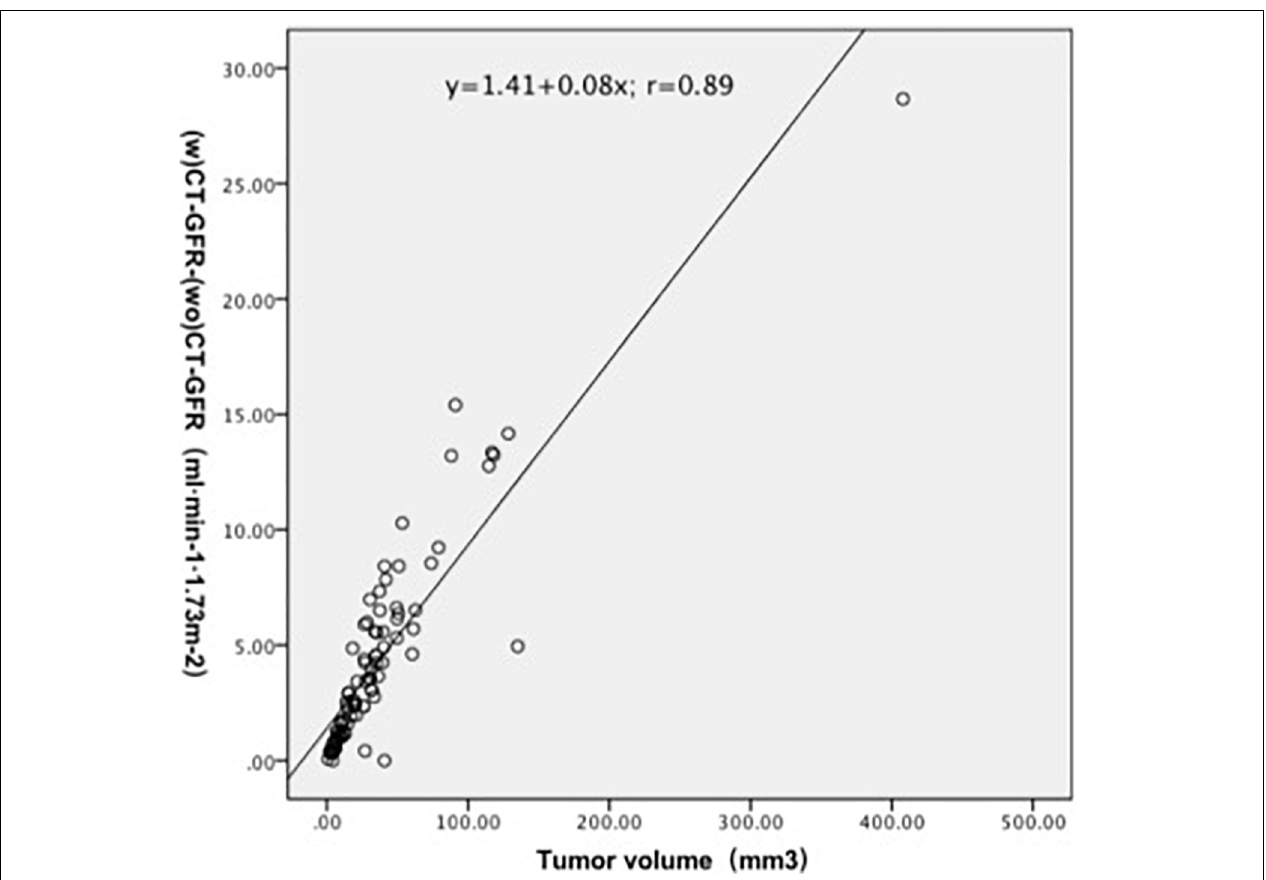
FIGURE 3 | Volume of renal tumor significantly correlated with the value of CT-GFR that determined by subtracting the CT-GFR measurement without renal tumor from CT-GFR measurement with renal tumor ( r = 0.89, p < 0.001).